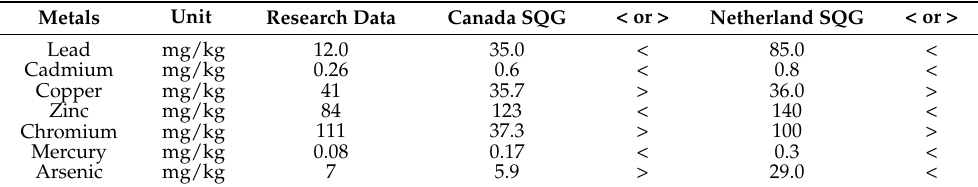
Table 10. Comparison of research data with Canadian’s and Netherland’s sediment quality guide- lines